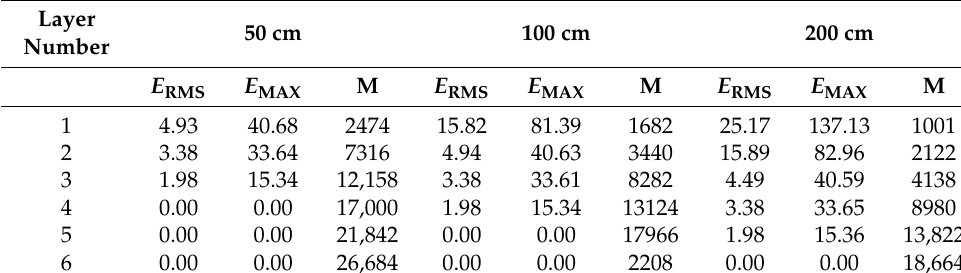
Table 2. The influence of the number of model layers on the approximation quality.